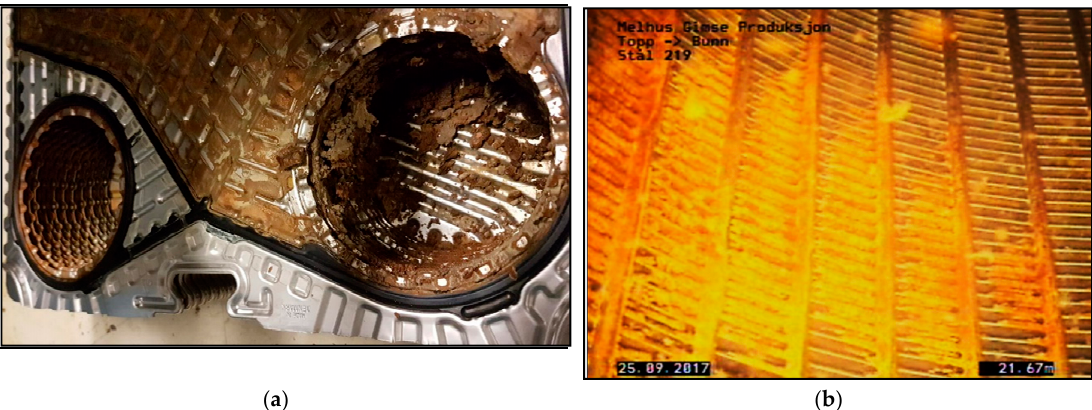
Figure 2. Clogging issues in Melhus. ( a ) Iron compounds and sediment inside a groundwater plate heat exchanger. ( b ) Local iron precipitation in the well screen surrounding the water inlet of a submersible pump in a production well. Affected area is approximately 20 cm in diameter and is probably caused by loss of hydrostatic pressure and gas exsolution during production.